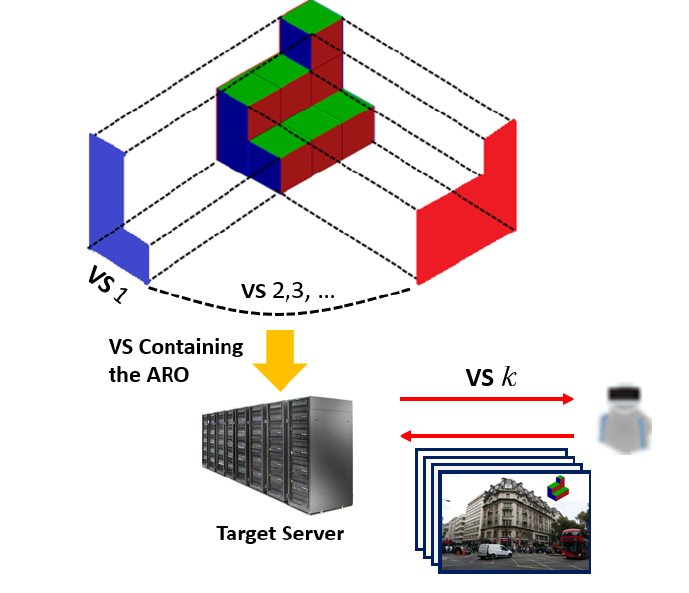
Figure 1. An example of multi-view streaming AR